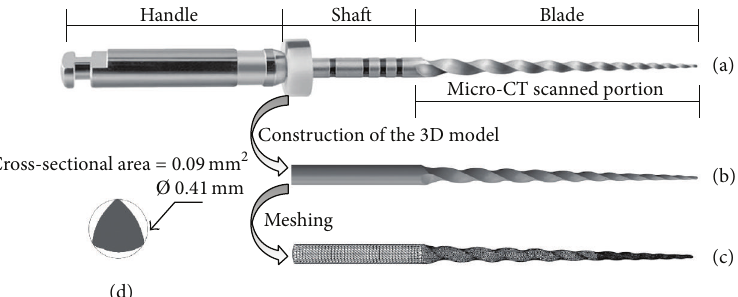
Figure 1: Construction of the finite element model: (a) ProTaper F1 endodontic instrument imaged using micro-CT scanning, (b) its 3D geometrical model, (c) the finite element model, and (d) the cross section of the file at 3mm from the tip.